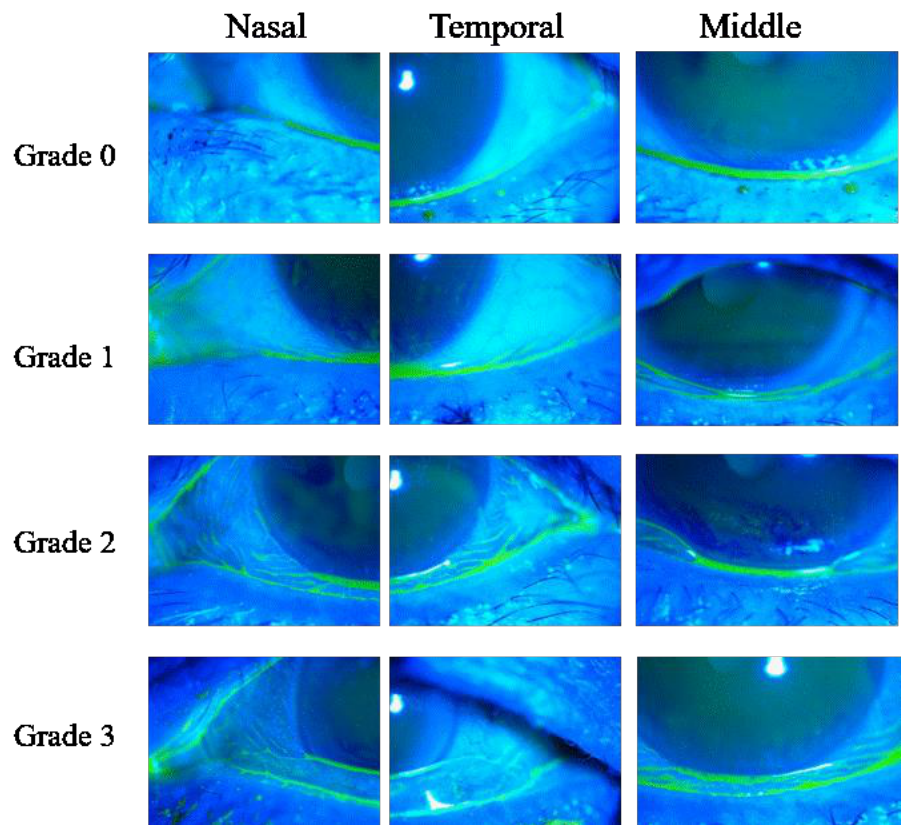
Figure 1. Images illustrating the grading system for conjunctivochalasis (CCh). Nasal and temporal area; Grade 0: no conjunctival fold, Grade 1: 2–3 conjunctival fords, Grade 2: several thick conjunctival folds, Grade 3: cystic or redundant conjunctival folds onto the lower lid margin. Middle area: Grade 0: no conjunctival fold, Grade 1: 2–3 folds appearing only after a forced blink, Grade 2: folds always existing with normal tear meniscus, Grade 3: cystic or redundant conjunctival folds onto the lower lid margin.